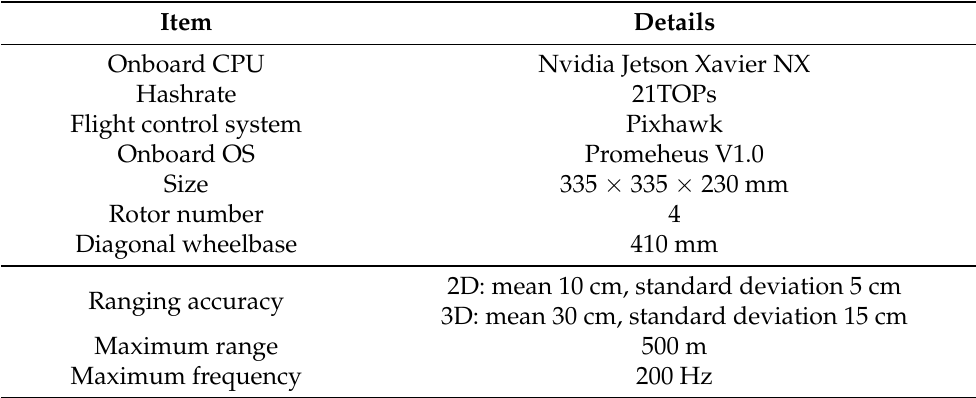
Figure 7. Sensor and UAV adopted in this study: ( A ) LinkTrack-P UWB rangefinder (NoopLoop, Shenzhen, China); ( B ) P450 UAV (Amovlab, Chengdu, China). Table 5. Hardware